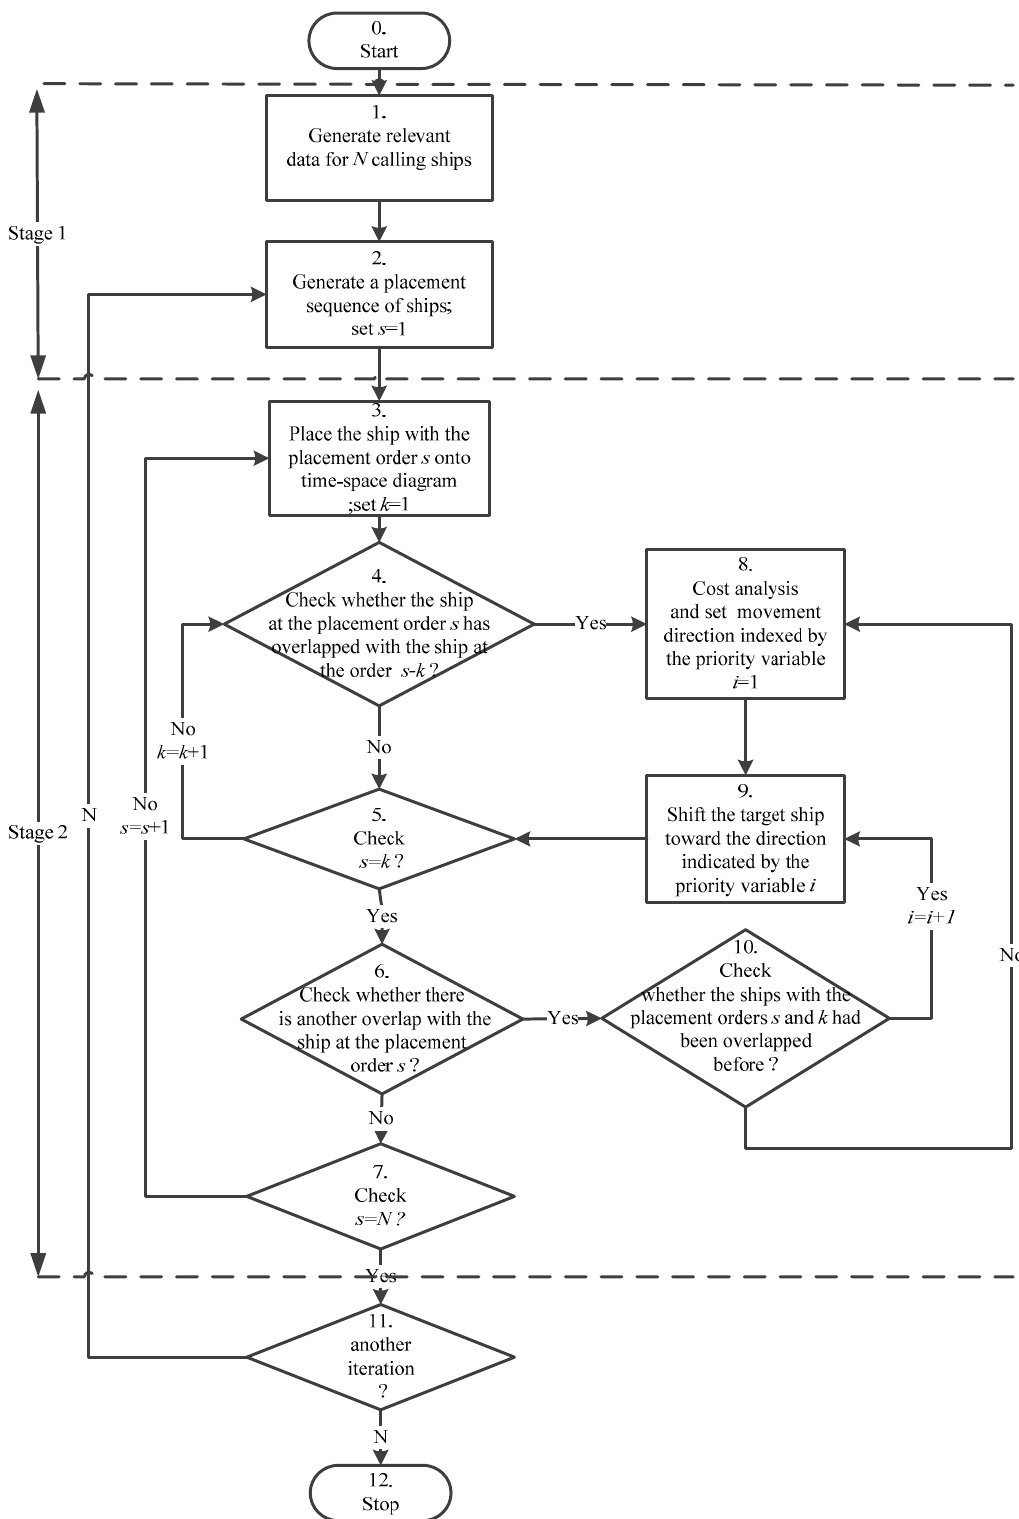
Figure 10. The main flow of the two-stage procedure.